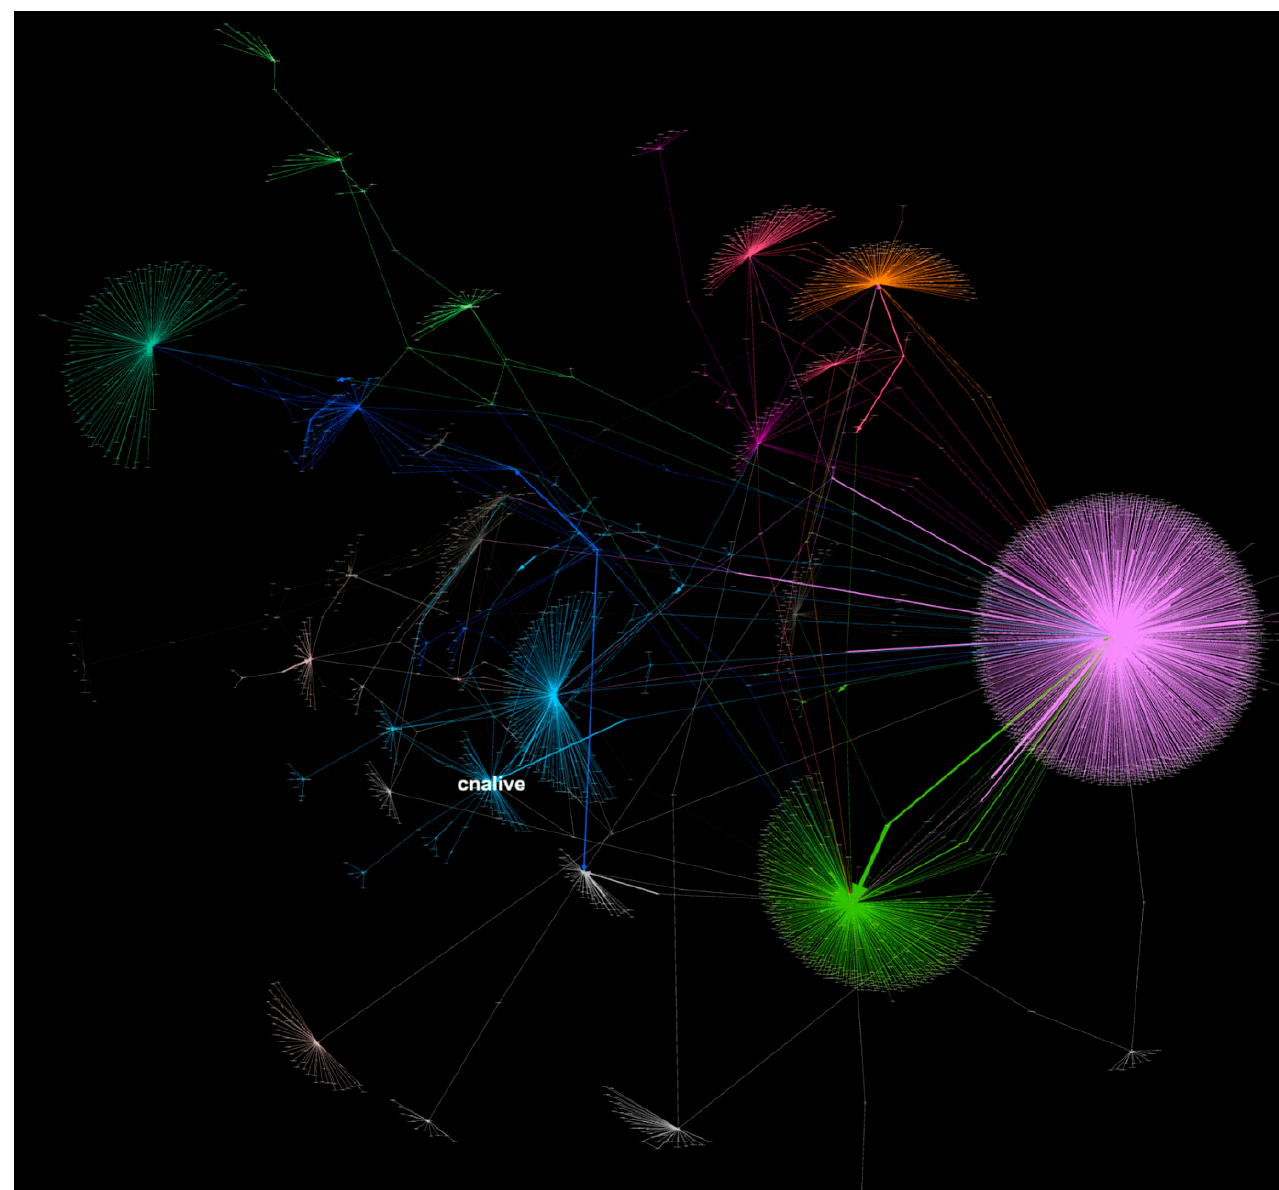
Figure 9. Twitter mentions graph (created in Force Atlas 2 and Fruchtenman Reingold layouts) represents Catholic and lay communities engaged in dissemination and discussion surrounding the Pope’s announcement. The initial announcements from Pontifex (Pope Francis Twitter’s account) and Catholic News Agency—represented by the blue areas in the centre—are re-broadcasted by large international news networks, such as CNN, Reuters, CBS, NBC, ABC, represented by purple, green orange and red areas to the right.